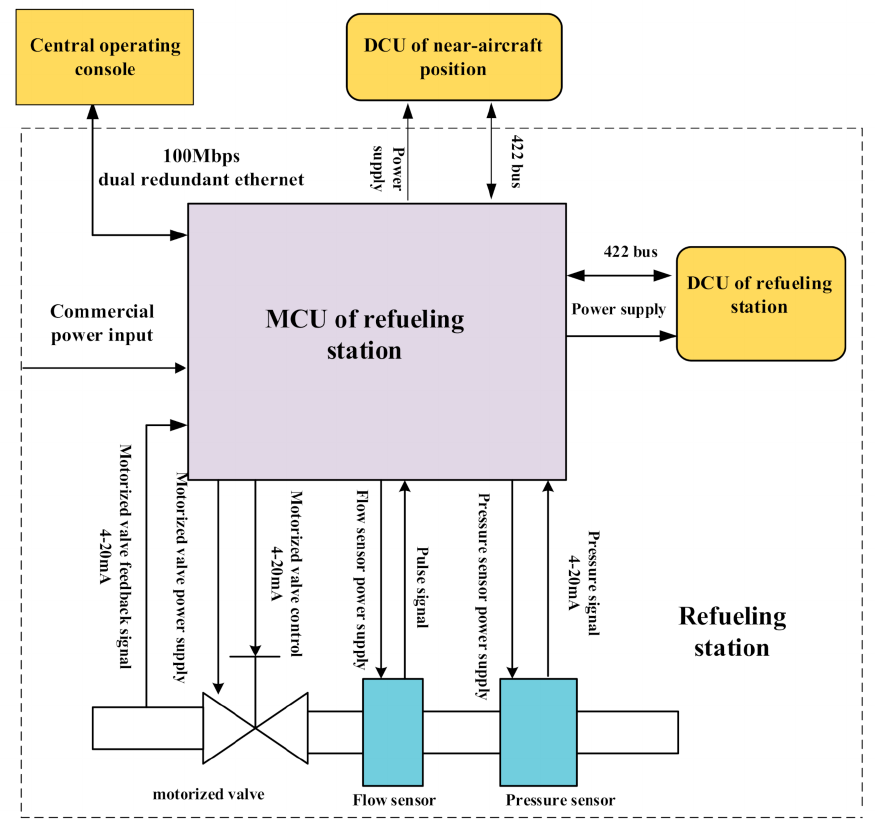
Figure 1. System structure. MCU: main control unit; DCU: display control unit.